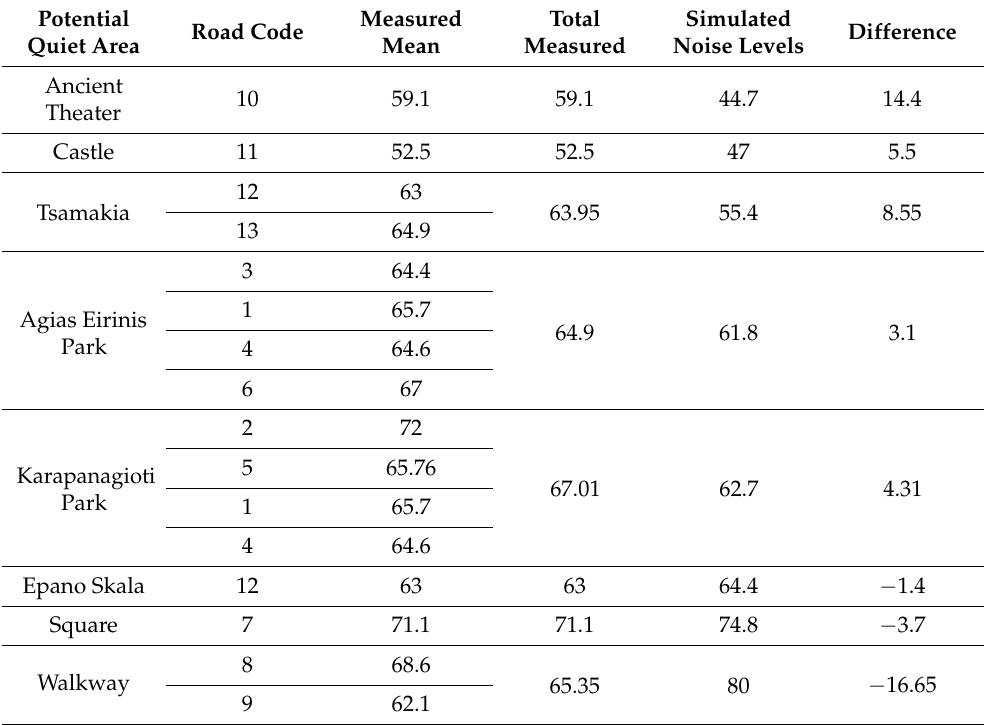
Table 2. Measured noise levels and simulated noise levels for each potential quiet area.